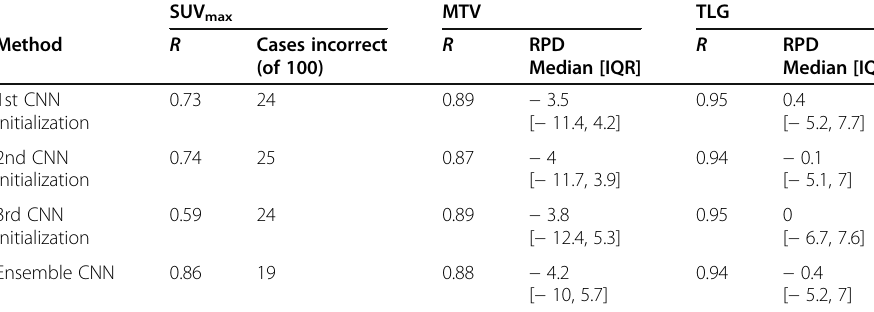
Table 2 Impact of using an ensemble of CNNs on quantification for the pediatric lymphoma population. Shown are results for SUV max , MTV, and TLG as summarized by Pearson ’ s correlation coefficient, R , and the relative percent difference when compared to physician measurements SUV max MTV TLG Method R Cases incorrect (of